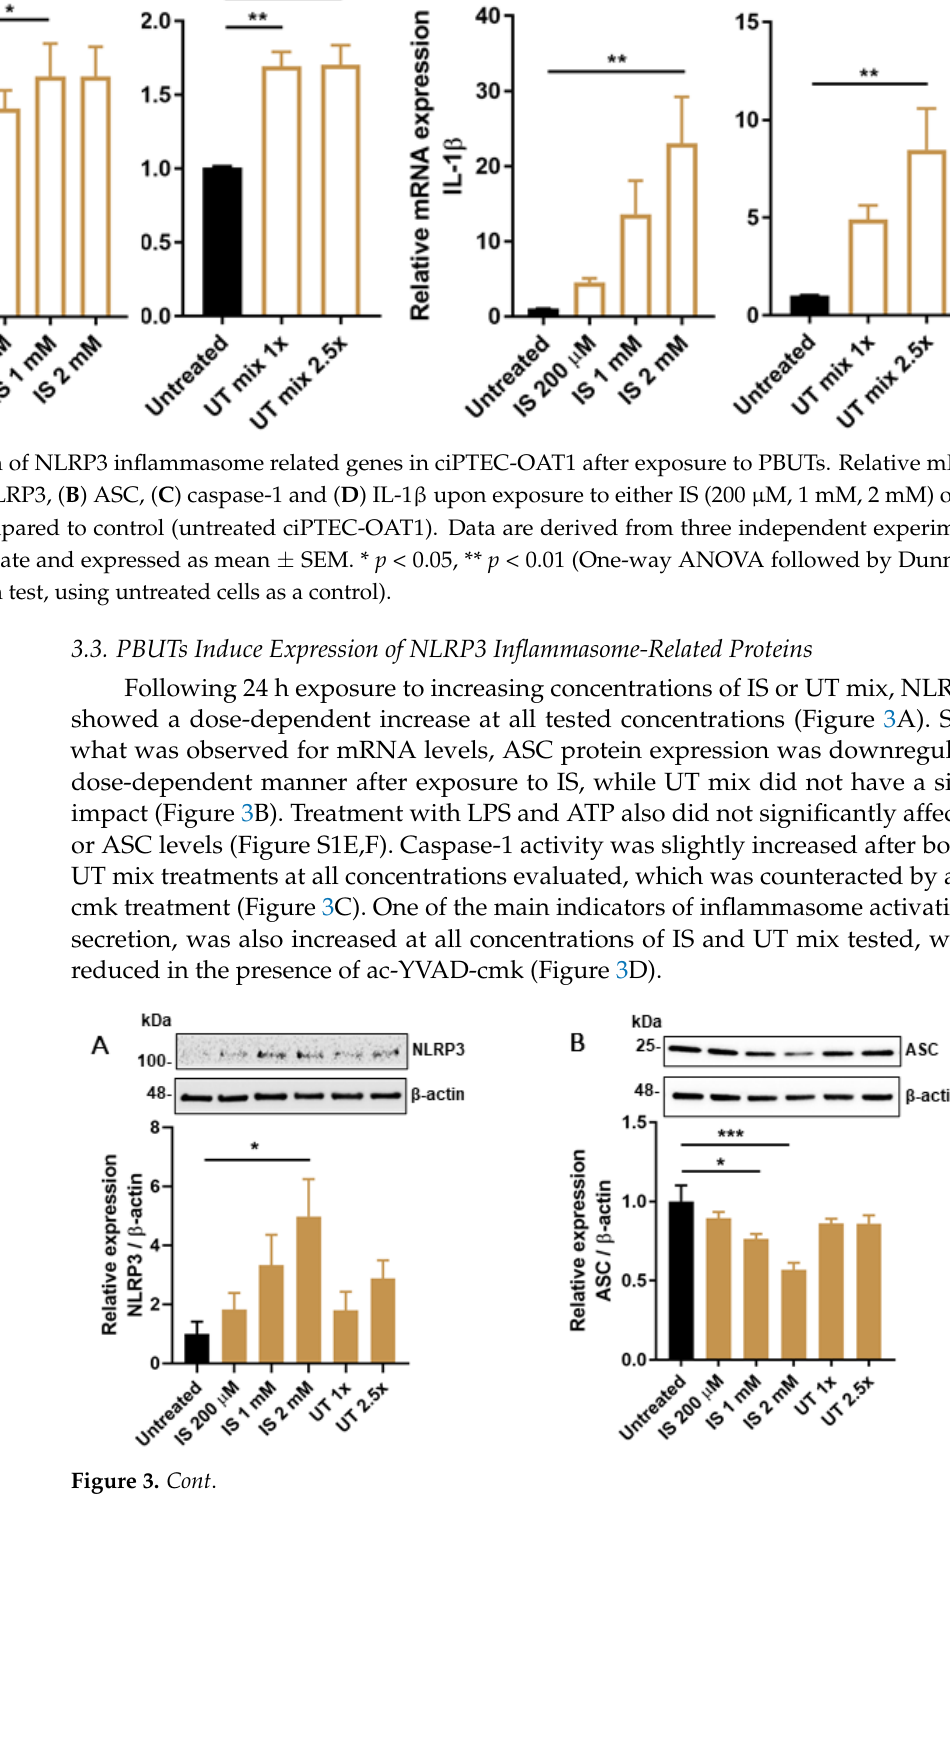
Figure 3. Effect of PBUTs on protein levels or functional activity of NLRP3 inflammasome-related components in ciPTEC-OAT1. Representative Western blot and quantification of relative expression of ( A ) NLRP3 and ( B ) ASC in ciPTEC-OAT1 following 24 h exposure to IS (200 μ M, 1 mM, 2 mM)